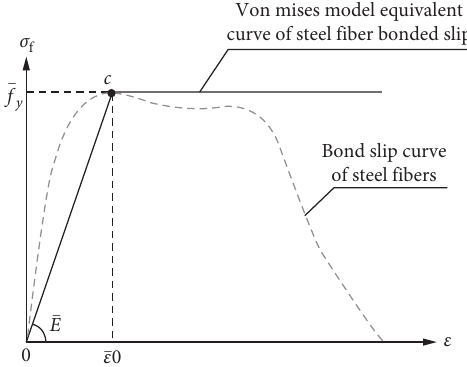
Figure 7: Equivalent von Mises model of steel fibre bonded slip.